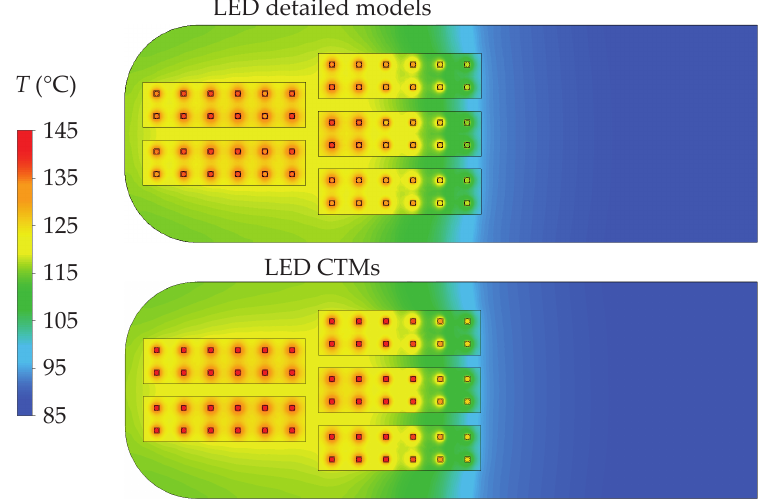
Figure 11. Surface temperature of the LED luminaire-level model with LED detailed models ( top ) and LED CTMs ( bottom ). For the LED CTMs, the temperature of the internal junction node is plotted on the LED